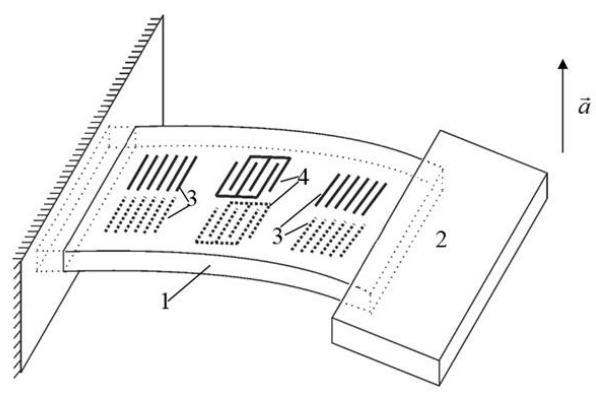
Figure 3. The overall schematic design of the SAW-based accelerometer.